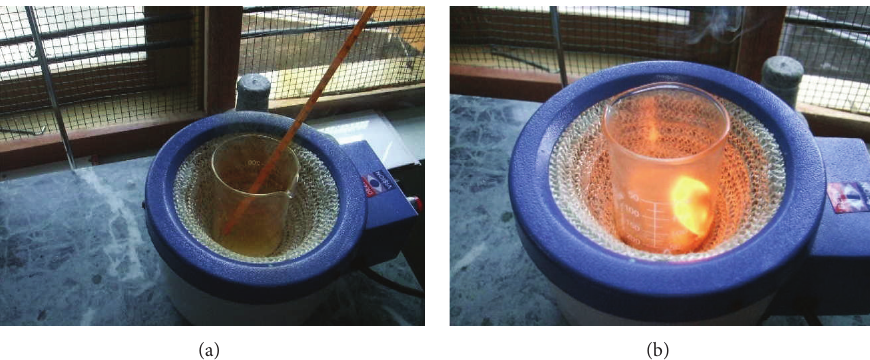
Figure 2: Slow evaporation (a) and observation of flame during combustion between nitrate and fuel (b) in the synthesis of MgO.